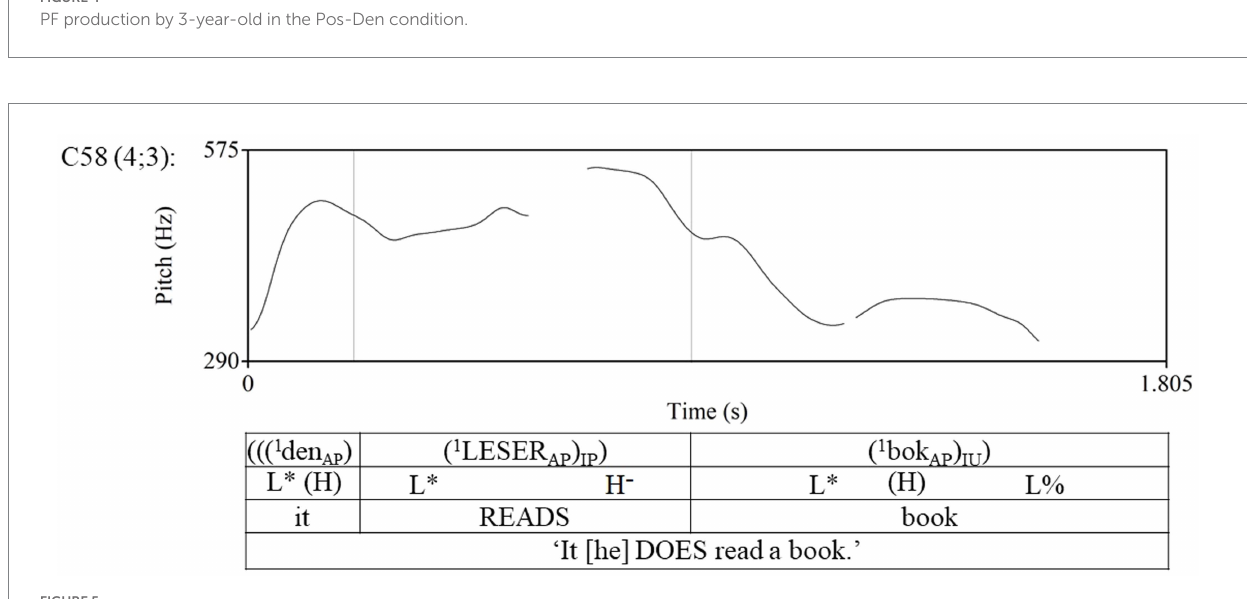
FIGURE 5 PF production by 4-year-old in the Neg-Den condition.